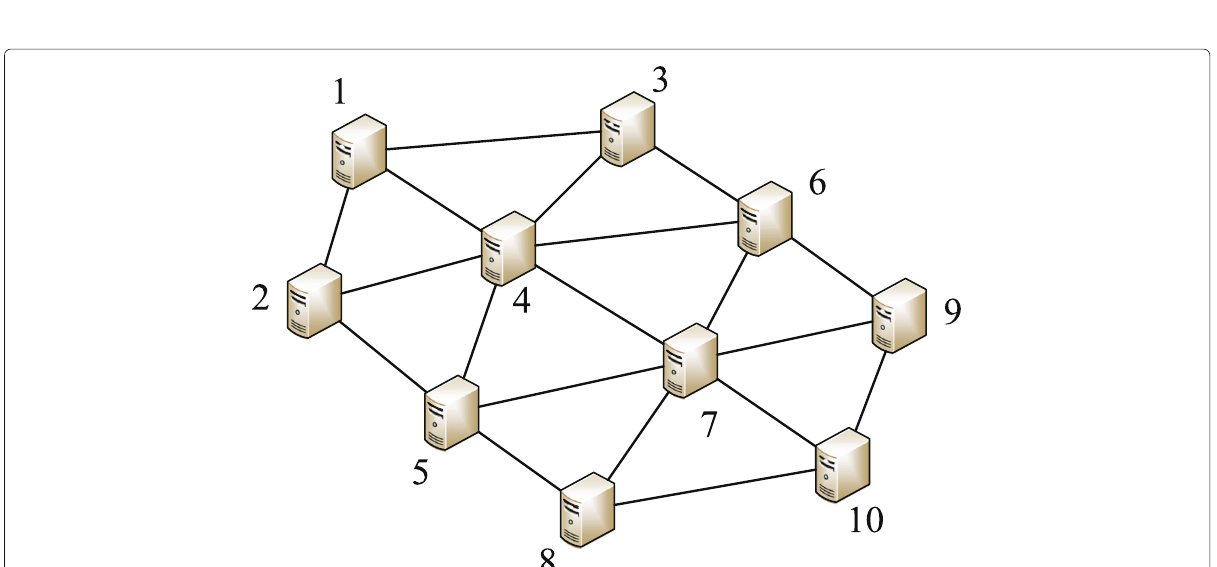
Fig. 3 Diagram of the topological structure of the distributed edge computing